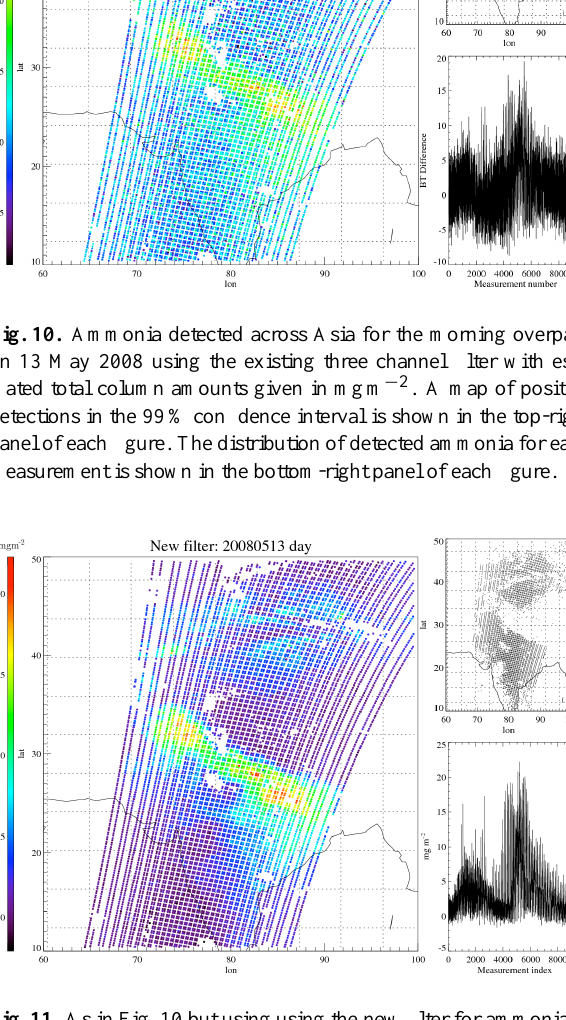
Fig. 11. As in Fig. 10 but using using the new filter for ammonia.